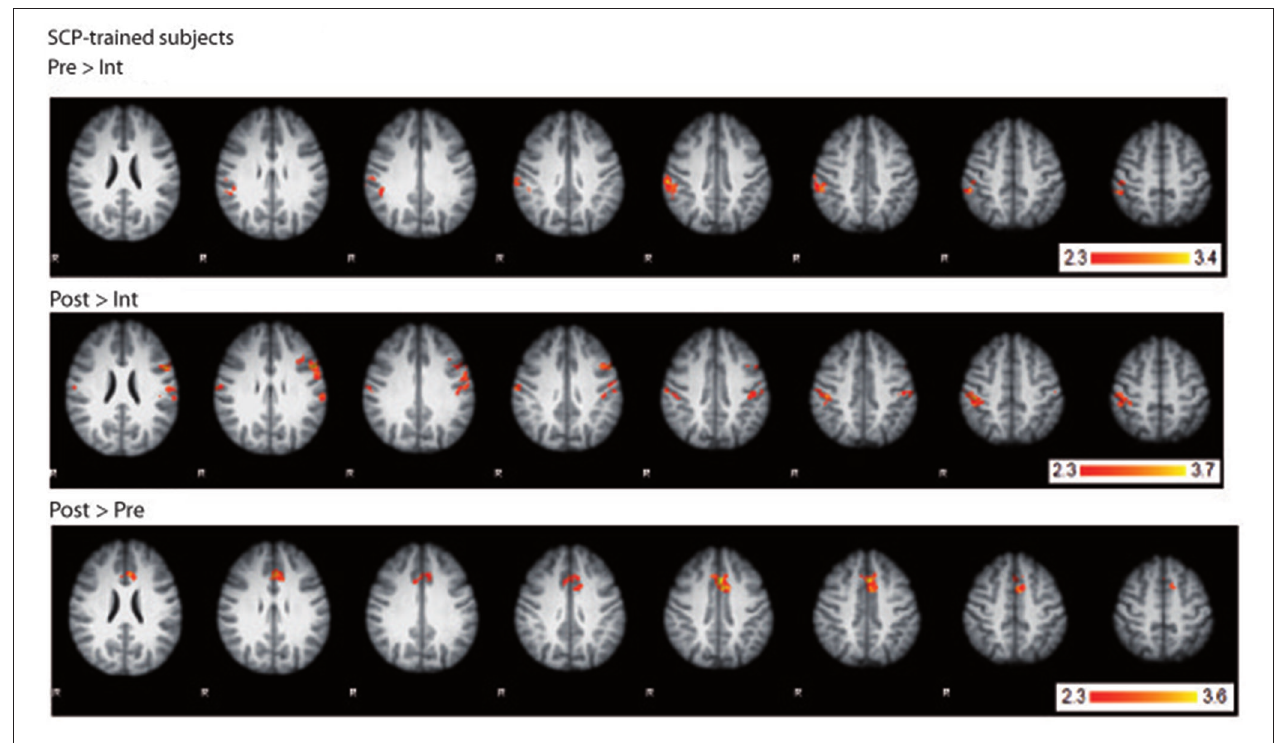
the post- compared to the intermediate measurement. Bottom: BOLD-activation higher in the post- compared to the pre- measurement. R =